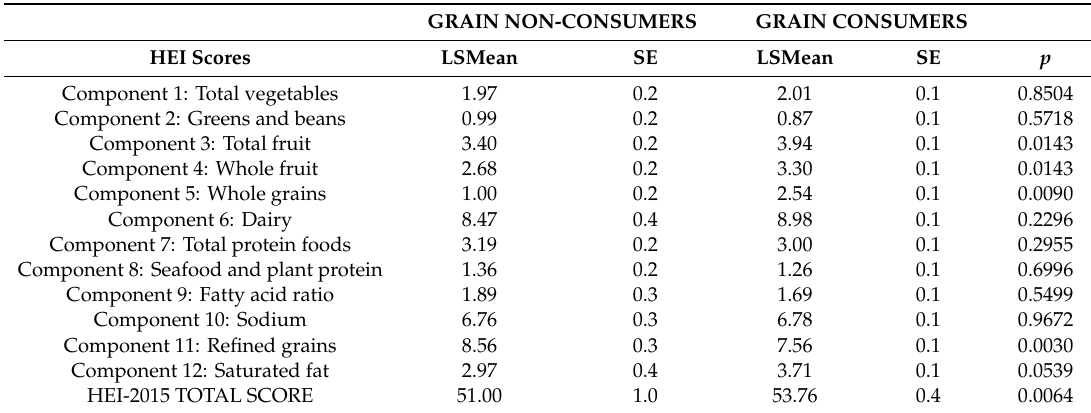
Table 4. Mean (SE) total and sub-component scores for the Healthy Eating Index 2015 (HEI-2015) in 13- to 23-month-old grain consumers vs. grain non-consumers.